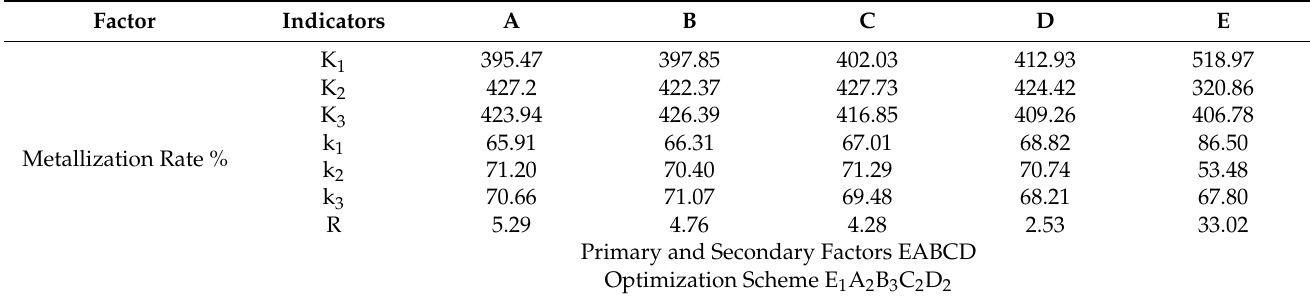
Table 5. Result analysis of metallization